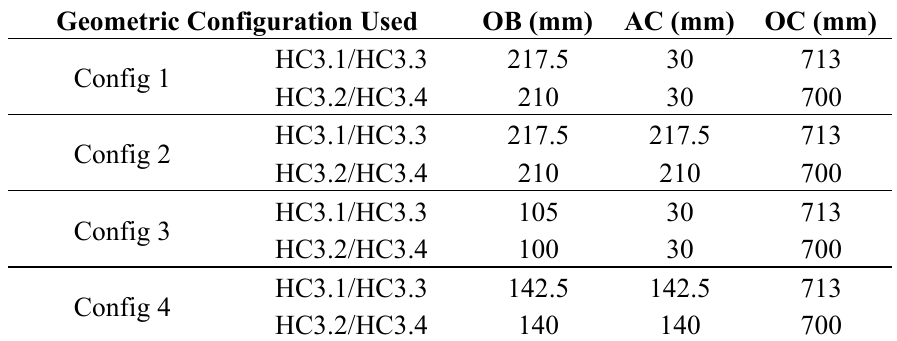
Figure 9. Torque arm position versus time of the array cylinders using Config 1. Table 10. Geometric parameters of the hydraulic cylinder fixation for model